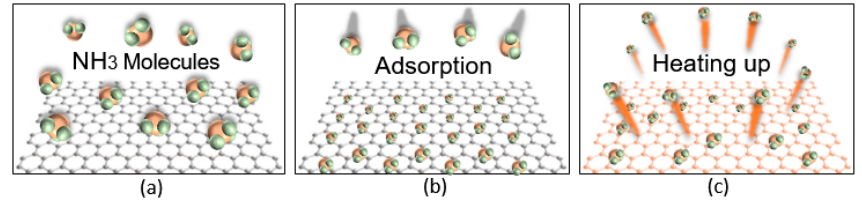
Figure 2. Conceptual process of interaction between molecules and graphene sheet. ( a ) The graphene has a steady condition without gas adsorption. ( b ) Molecules are adhered by interaction bonding. ( c ) Desorption occurs by air purging and annealing that accelerates desorption.